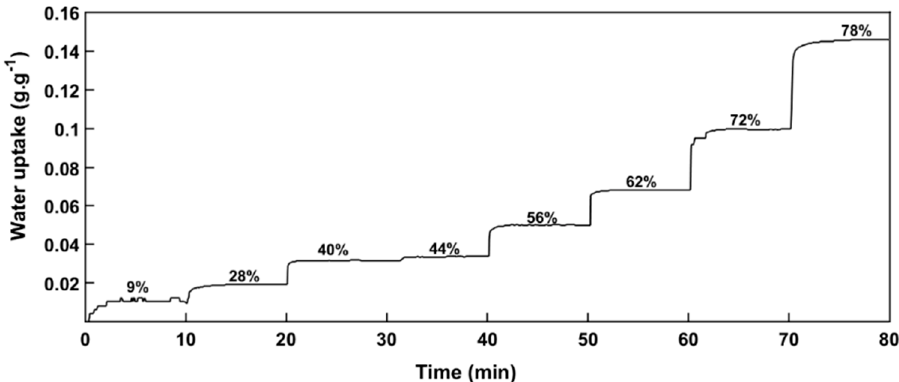
Figure 5. Water vapor sorption kinetic of cellulose particles measured by quartz crystal microbalance (QCM). The mentioned percentages correspond to the successive relative humidity steps.